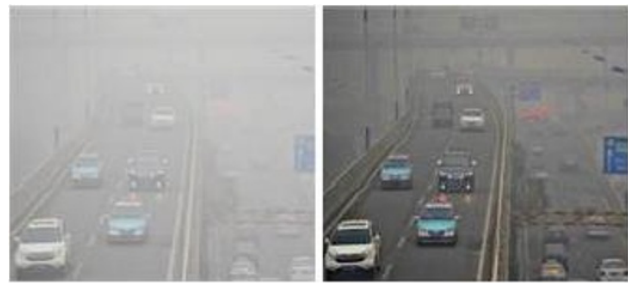
Fig. 8. An example of an algorithm based on the YCrCb